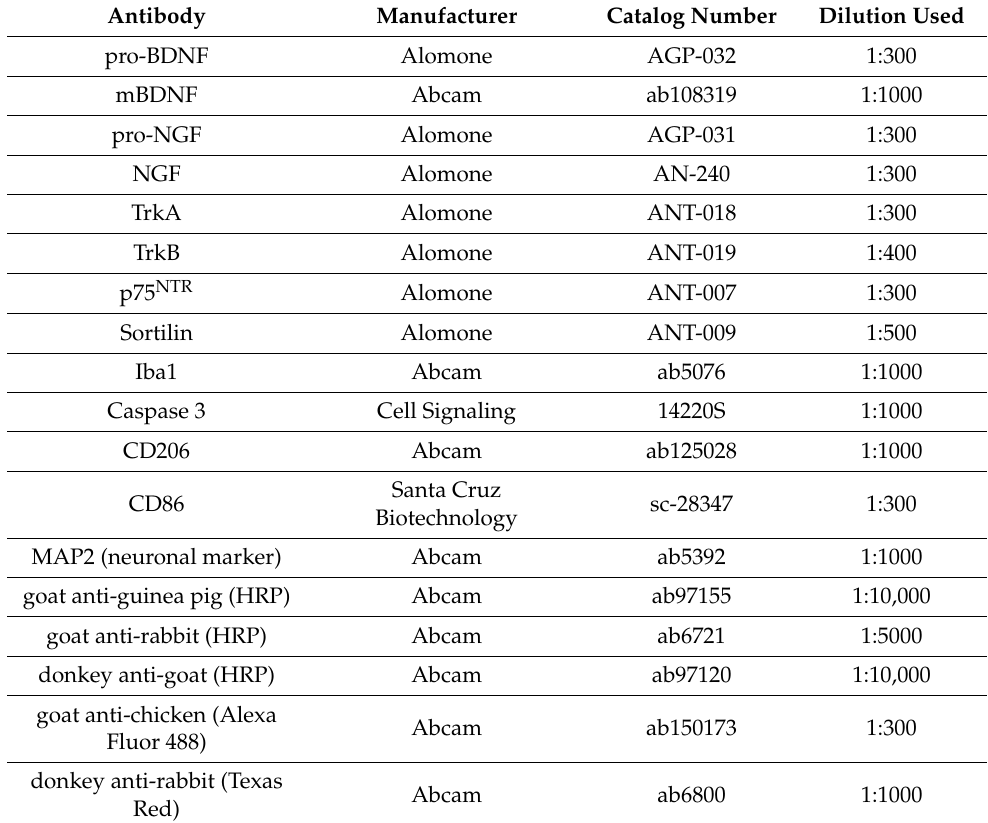
Table 1. The list of primary and secondary antibodies used in Western blot and fluorescence mi- croscopy